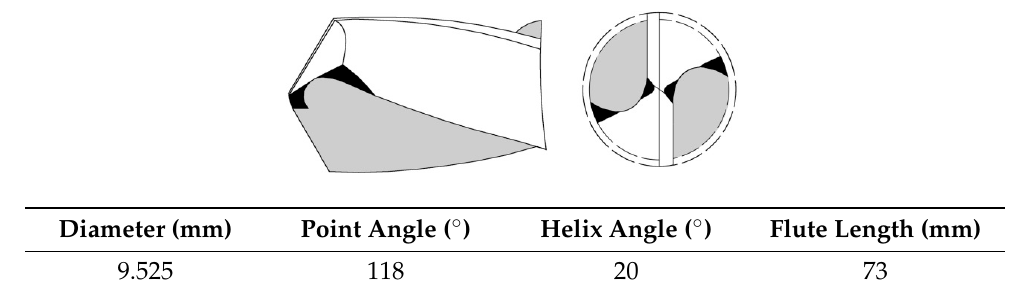
Figure 2. Schematics of the drill and its geometric information.